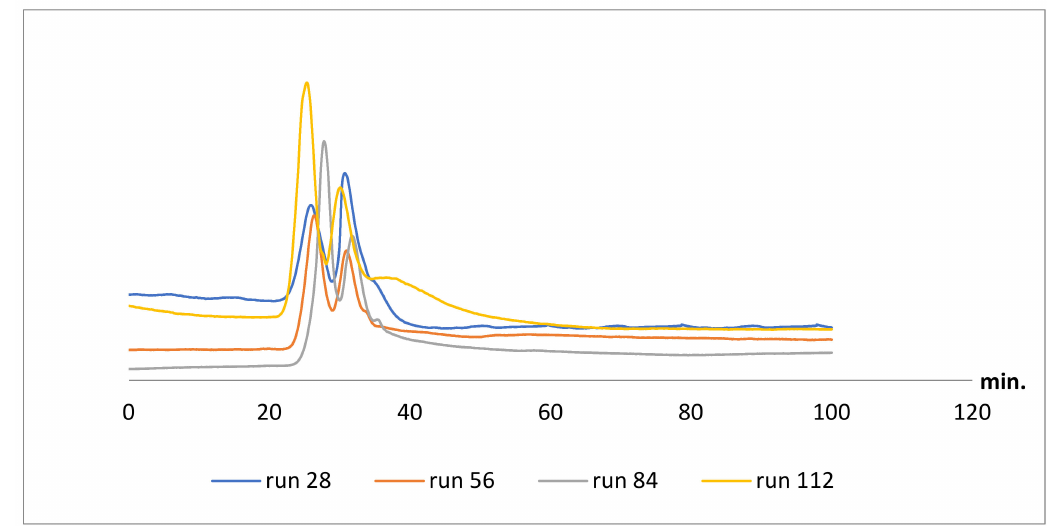
Figure 8. The loadability of the monolithic columns of pindolol started at run number 28 up to run number 112, mobile phase: ACN/water 20:80 v/v , UV: 219 nm, flow rate: 1 µ